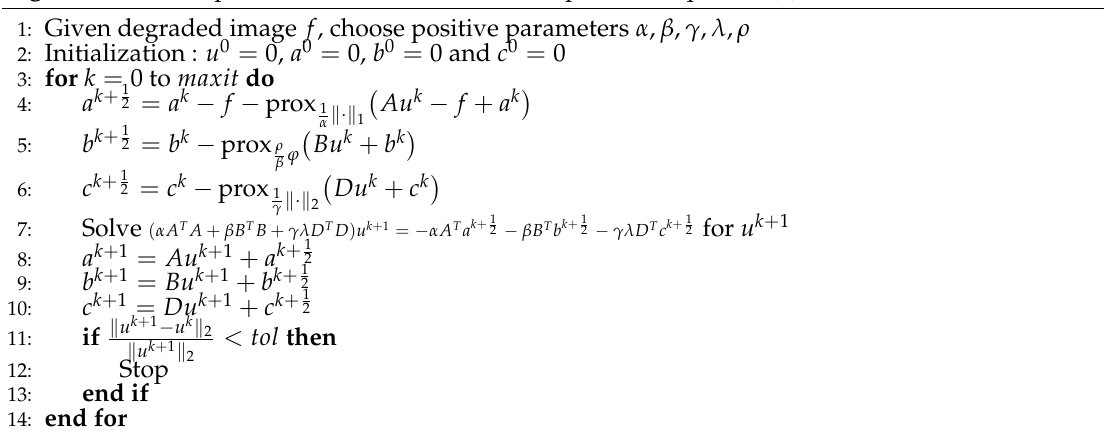
Algorithm 4 Fixed-point-like method for the TVL1 problem Equation